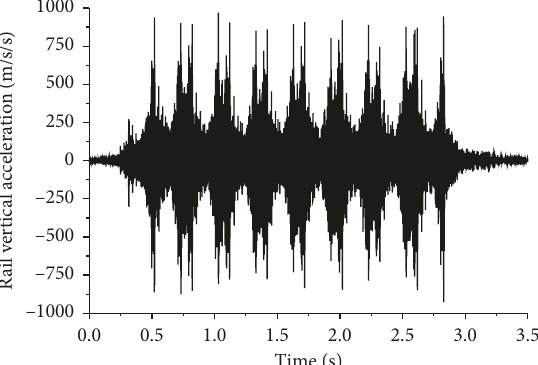
Figure 5: Rail response in the time domain.